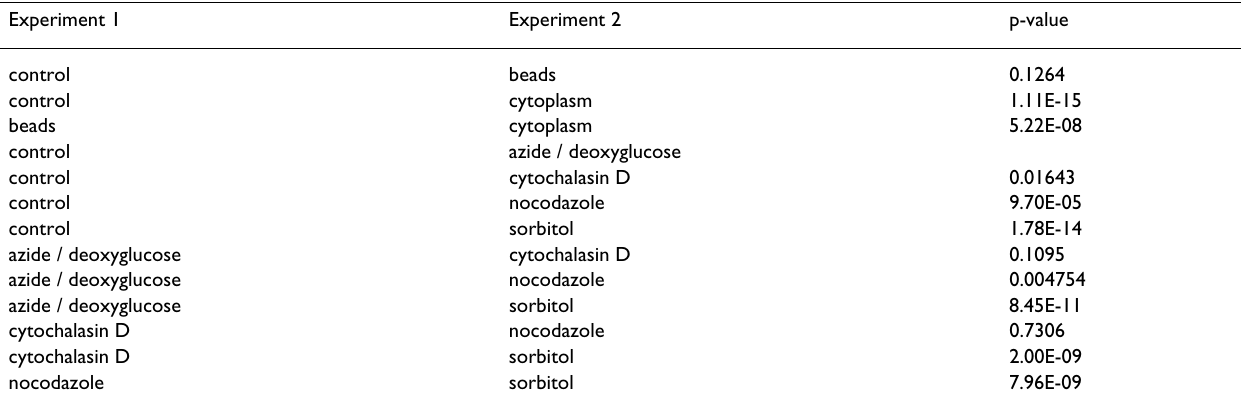
Table 1: Significance analysis of interexperimental differences in distribution of anomalous diffusion coefficients by Kolmogorov – Smirnov test Statistical significance analysis for interexperimental differences in cumulative distribution of anomalous diffusion coefficients (for corresponding distribution plots see Figure 5 and Figure 9) was performed by the Kolmogorov – Smirnov test [45]. The different experiments are depicted as followed: control = vimentin particles in the nucleus; beads = sepharose microspheres (100 nm) in the nucleus; cytoplasm = vimentin particles in the cytoplasm; Vimentin particles in the nucleus with drug treatment: azide / deoxyglucose (10 mM / 50 mM); cytochalasin D (1 µ g/ml); nocodazole (0.04 µ g/ml); sorbitol (600